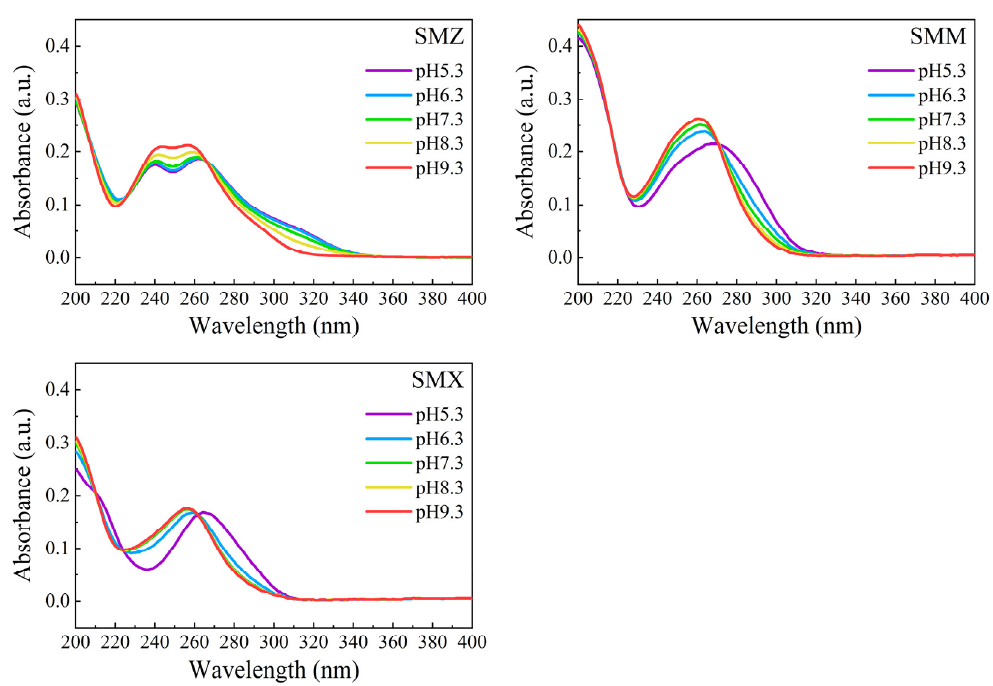
Figure A1. Distribution coefficients ( ẟ ) of sulfonamides (“+”, no mark, and “–” represent cationic, neutral, and anionic species, respectively) and HOCl at different pH. SMZ: pKa = 2.3, 7.4; SMM: pKa